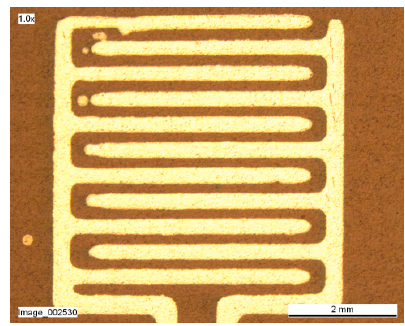
Figure 2. Picture of the bottom interdigitated electrode printed by inkjet process.